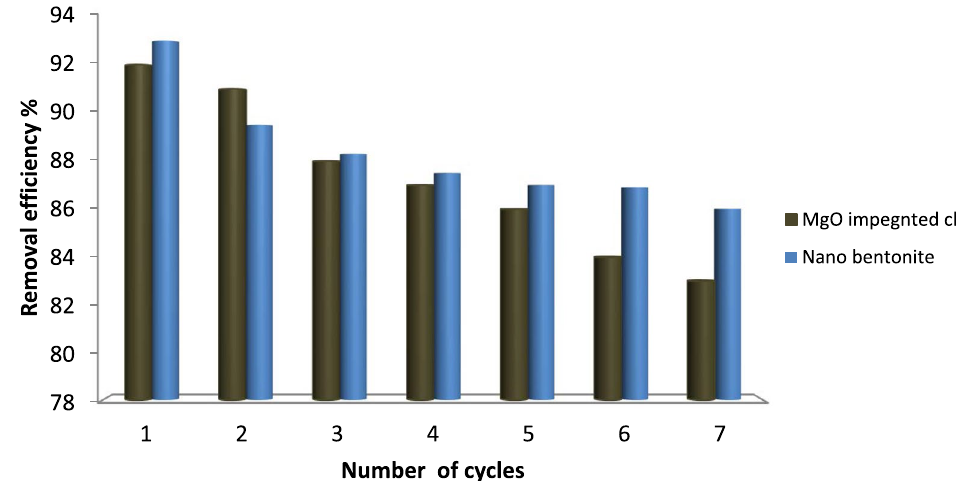
Fig. 25 Percentage removal (%) of the adsorption–desorption cycles of nano-bentonite and MgO impregnated